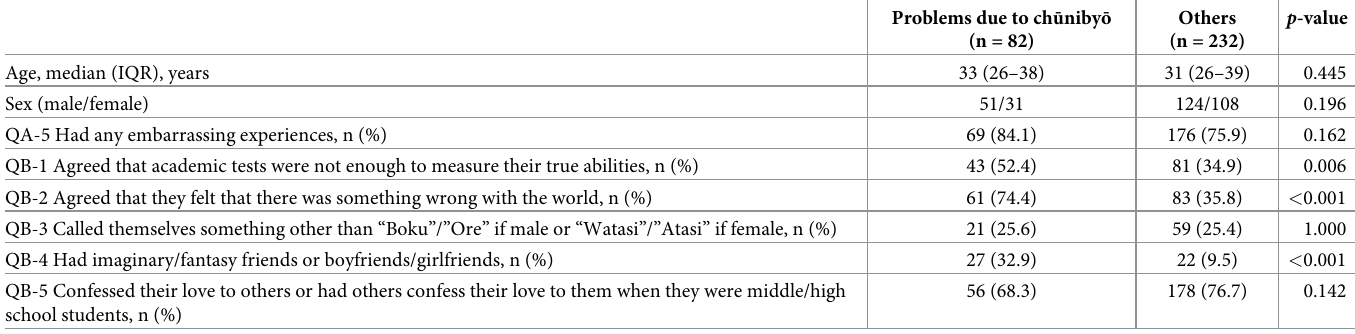
Table 3. Comparisons between people who experienced problems due to ch ū niby ō and